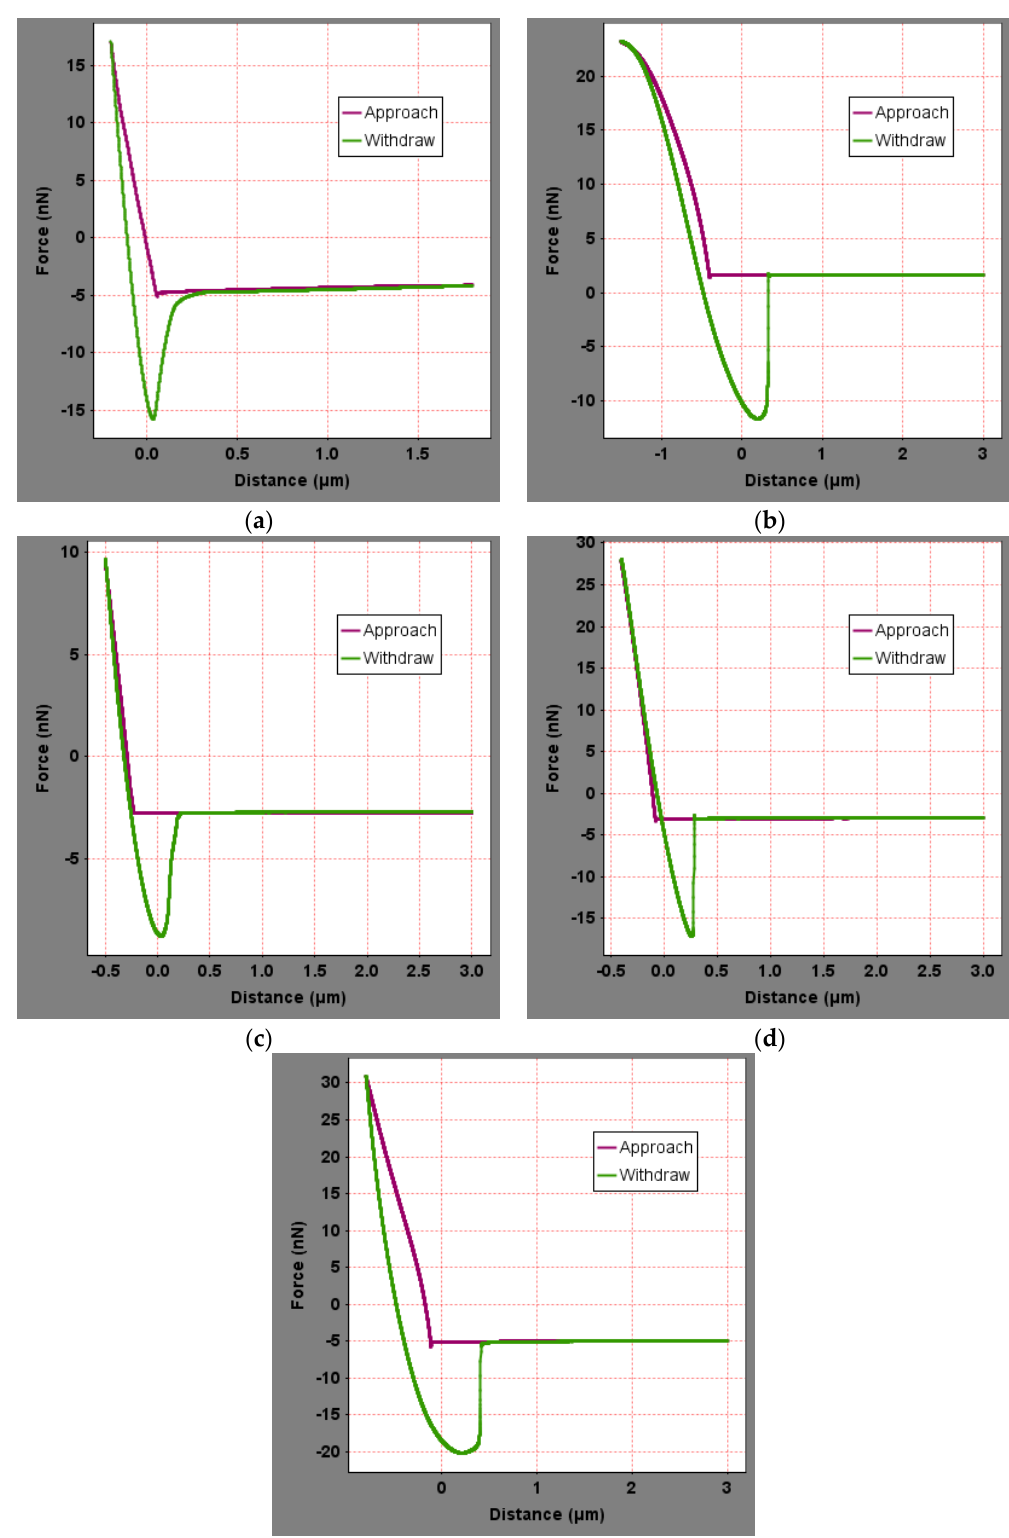
Figure 15. Force curves of the other regions of the bee-like structures in soaked asphalts: ( a ) SK-70; ( b ) SK-90; ( c ) KL-70; ( d ) Shell-70; and ( e ) SBS-modified.